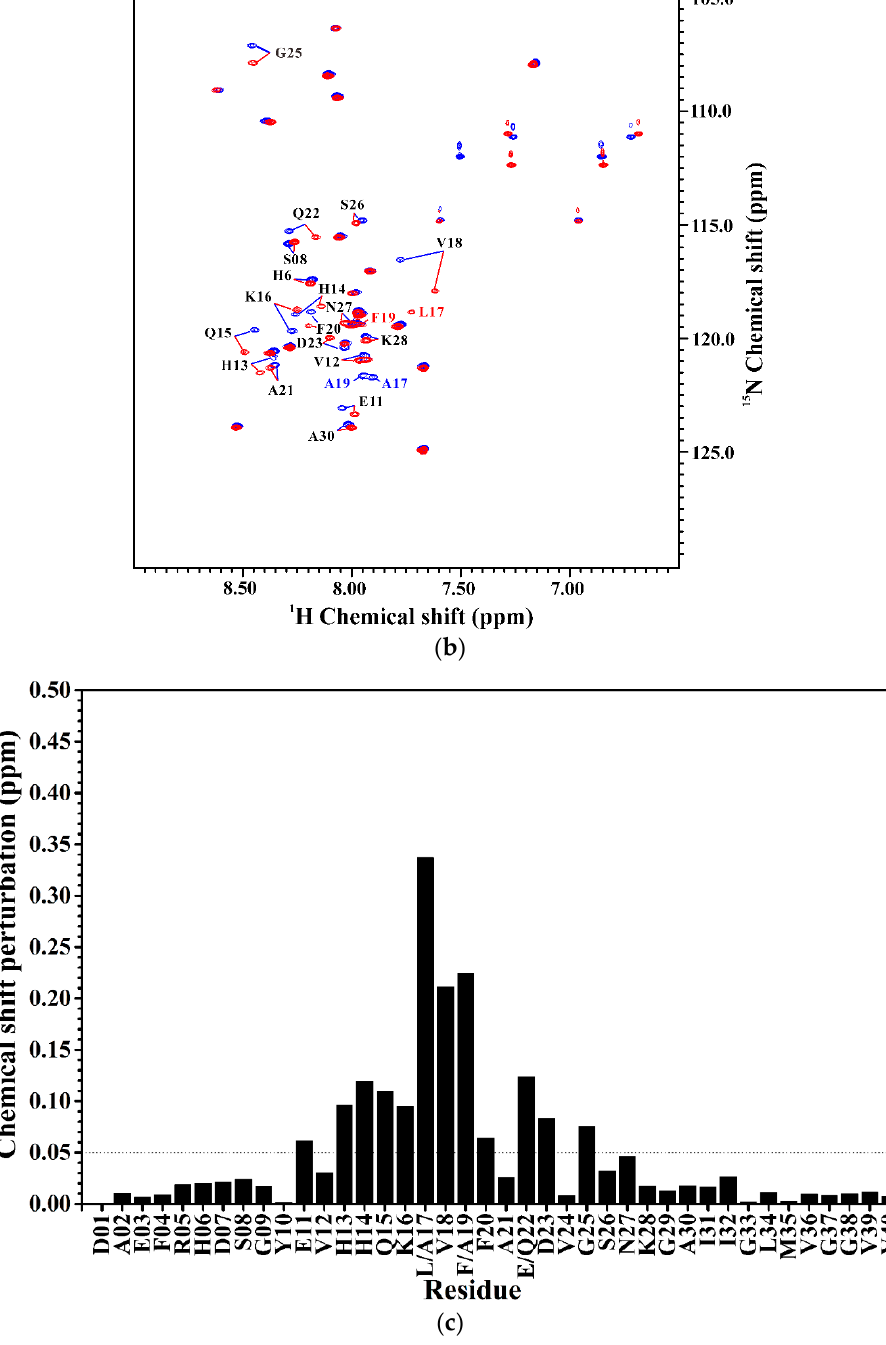
Figure 5. ( a ) Two-dimensional 1 H- 15 N-HSQC spectrum of 15 N-labeled A β 40 (L17A/F19A/E22Q) in 100 mM SDS micellar solution at 296 K; ( b ) Overlay of Two-dimensional 1 H- 15 N-HSQC spectra of 15 N-labeled A β 40 (E22Q) (red) and A β 40 (L17A/F19A/E22Q) (blue) in 100 mM SDS micellar solution at 296 K. Residues which display chemical shift perturbations were labeled; ( c ) Chemical shift perturbation plotted as a function of residue number. Chemical shift perturbation was calculated using the equation [( HN Δ ppm) 2 + ( N Δ ppm/10) 2 ] 1/2 , where HN Δ ppm and N Δ ppm were equal to 1 HN and 15 N chemical shift differences between A β 40 (E22Q) and A β 40 (L17A/F19A/E22Q), respectively [31].